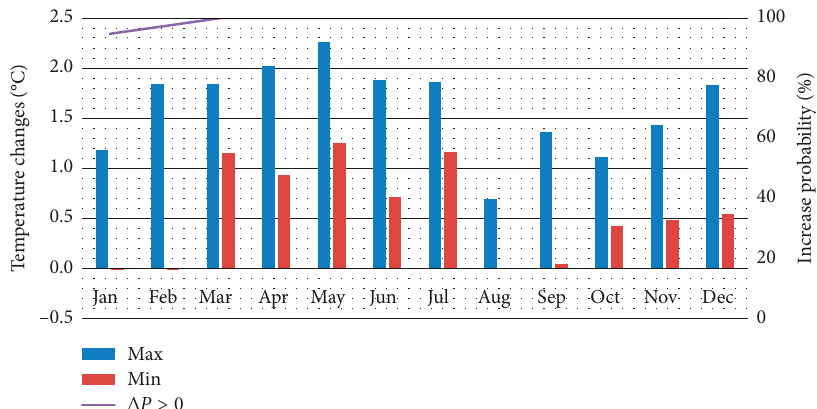
Figure 7: Range of changes in the monthly average of the maximum daily temperature in the future near period under all the models and three emission scenarios and their